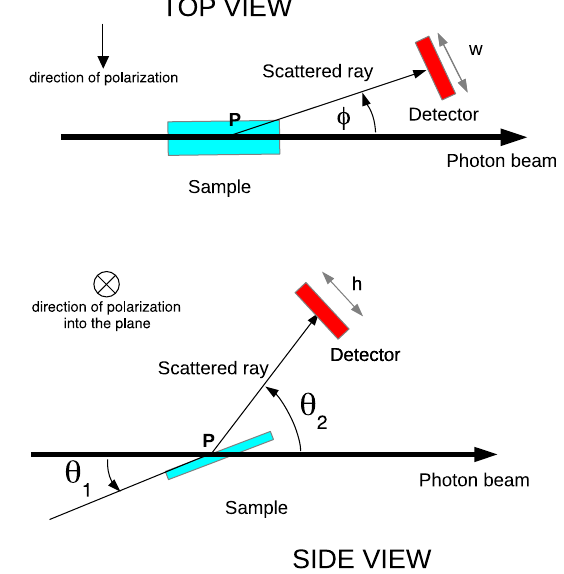
FIG. 14. Experimental setup, showing key angle